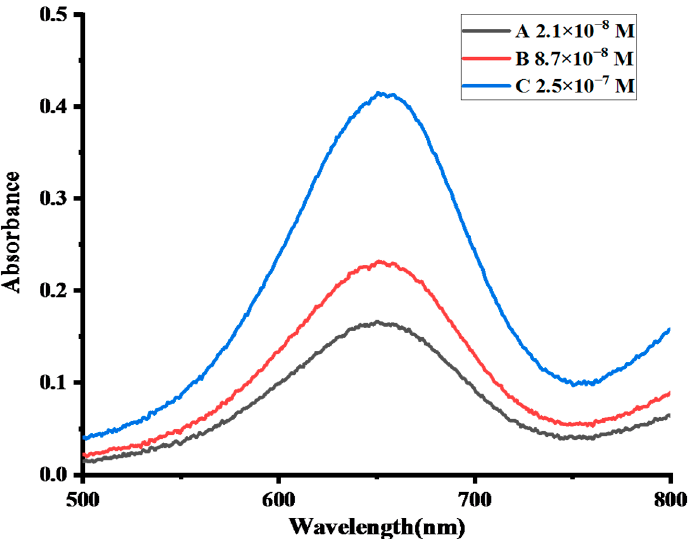
Figure 13. UV–Vis spectra of cancer patients’ urine samples under optimal conditions after the ad- dition of H 2 O 2 at different concentrations, including 2.1 × 10 − 8 M, 8.7 × 10 − 8 M, and 2.5 × 10 − 7